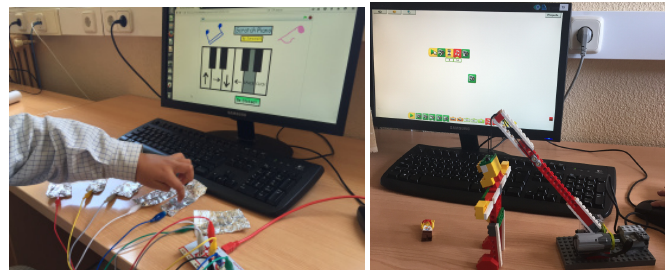
Figure 1. Different robotic prototypes to work in different educational